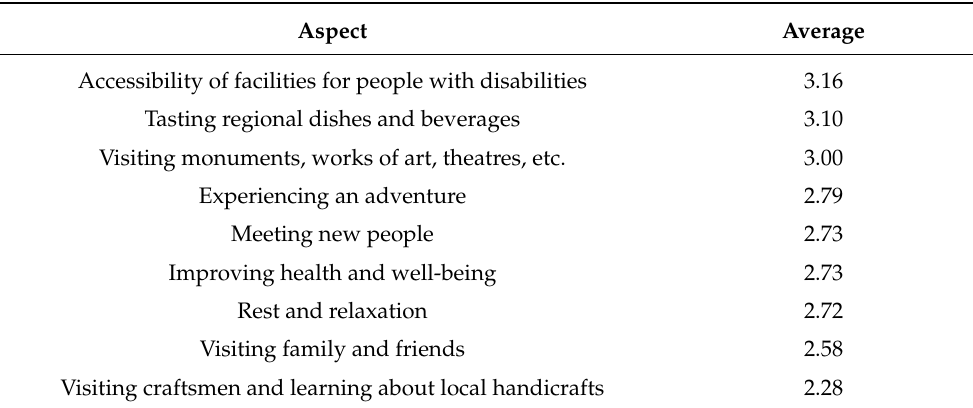
Table 7. Importance of various aspects of the trips.